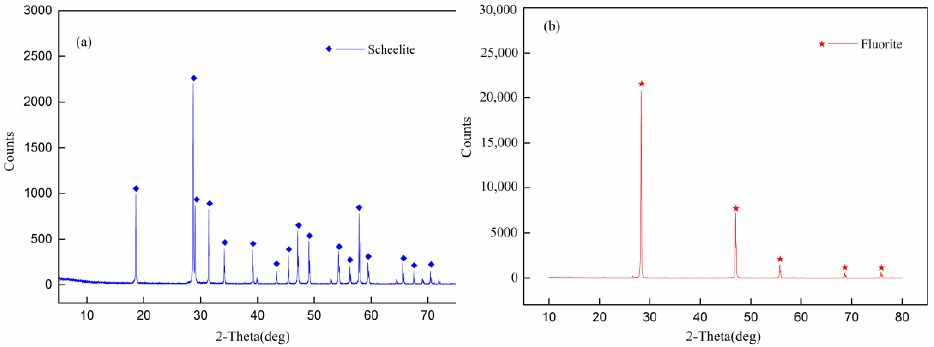
Figure 2. ( a ) XRD spectra of the scheelite and ( b ) fluorite test samples.